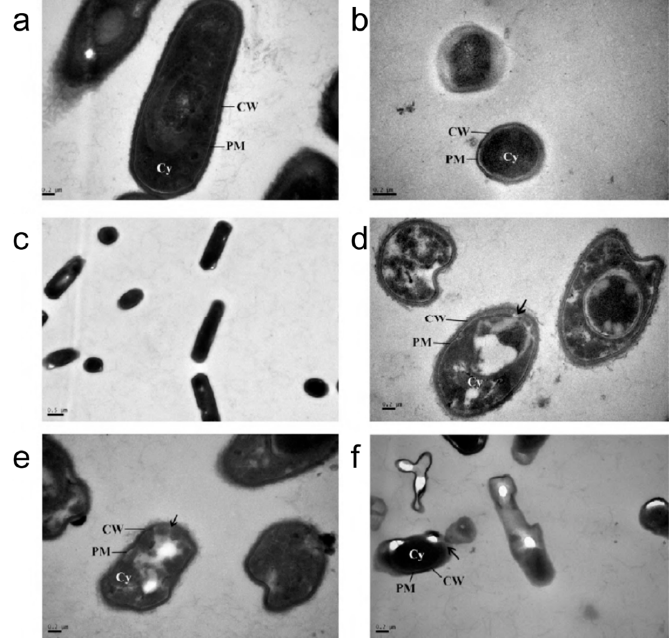
Figure 3. Transmission electron microscopy micrographs of untreated ( a ) E. coli ; ( b ) S. aureus ; and ( c ) B. subtilis cells. Corresponding TEM mircrographs of microemulsion-treated ( d ) E. coli ; ( e ) S. aureus ; and ( f ) B. subtilis cells. Reproduced with permission from Ref. [57].